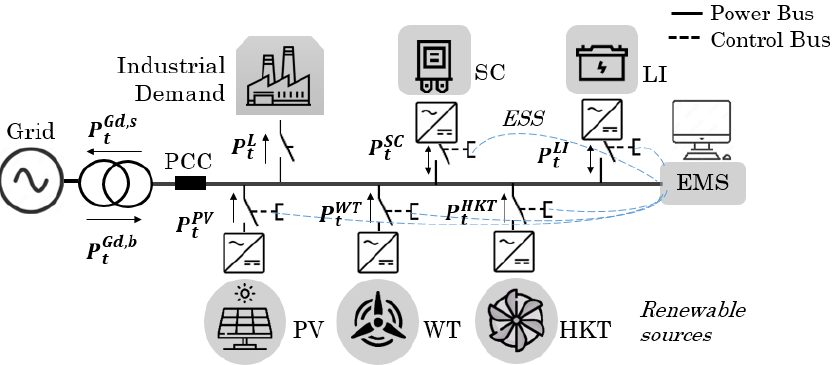
Figure 2. System topology and information flows of PV-HKT-WT-LI-Grid-Load demand and SC.